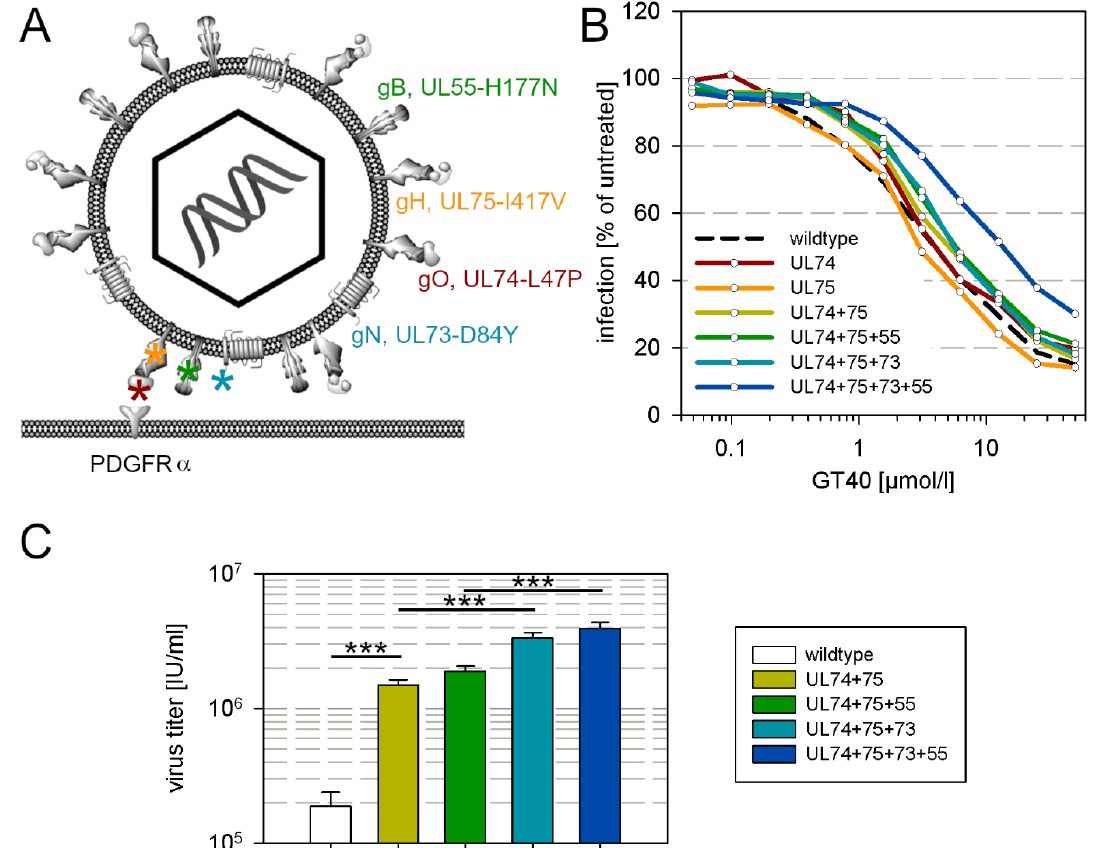
Figure 4. Mutations in envelope glycoproteins decrease sensitivity to GT40. ( A ) Localization of the mutations that were tested by marker transfer. ( B ) Each mutation or combination of mutations was introduced into two independent clones. Two independent virus supernatants were obtained from each clone. Thus, four virus supernatants were available for each combination, and each was independently tested twice, resulting in a total of eight replicates for each mutation combination. The supernatants were incubated for 2 h with different concentrations of GT40 and then added to HFFs. After overnight incubation, viral IE-Ag was stained by immunofluorescence and the number of infected cells compared to the untreated control was determined as the relative infection rate and plotted against the peptide concentration. ( C ) HFFs were infected at a low infection multiplicity of 0.01 infectious units per cell with wildtype pHB5 or mutants as indicated, GT40 was added at 25 µmol/L 3 d post infection and refreshed after 3 days. Virus supernatants were harvested at 11 and 12 d after infection, and the virus titers in the supernatants were determined. Bars indicate the mean of four experiments at 11 d and four experiments at 12 d; error bars indicate the standard error of the mean. Asterisks indicate statistical significance of the differences (*** = p < 0.001).